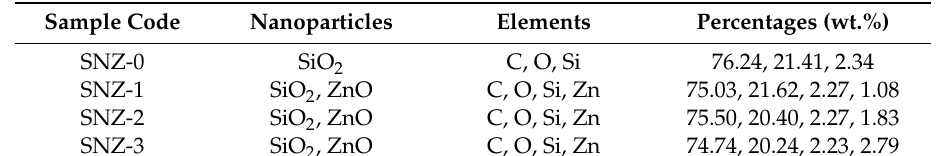
Table 4. Elemental composites of the prepared coatings and their weight percentages, detected by energy-dispersive X-ray spectroscopy (EDX).